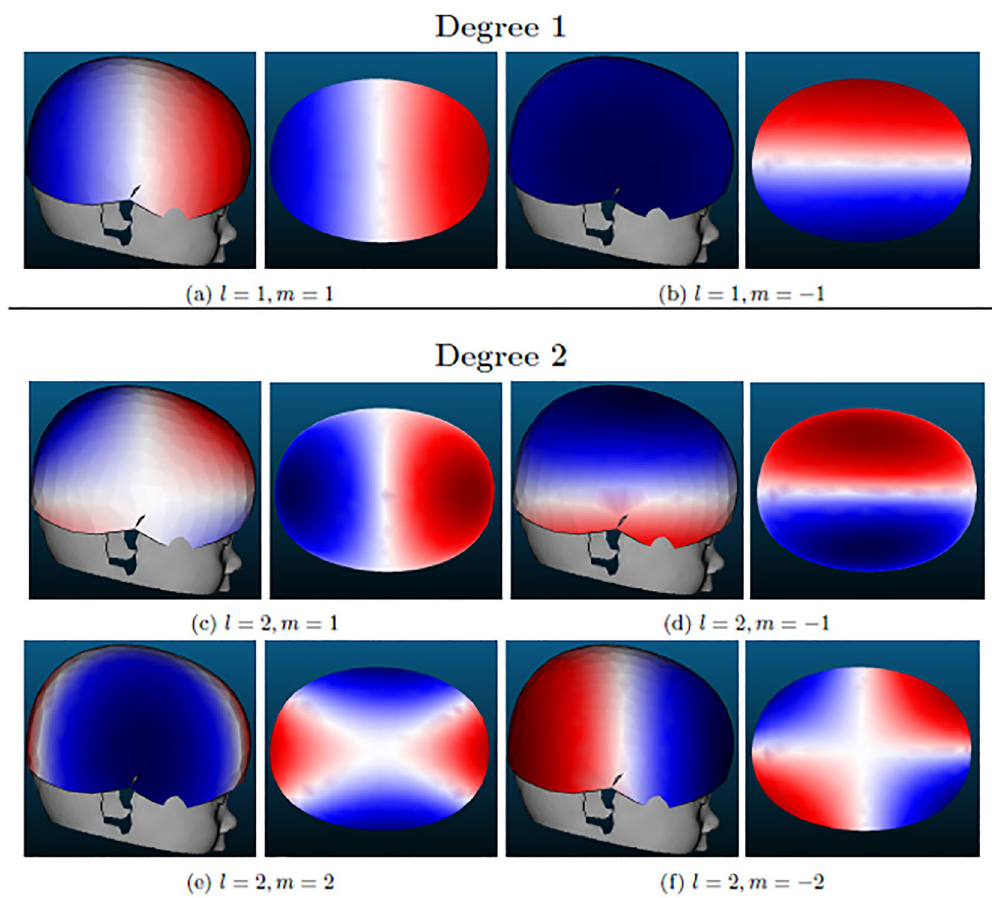
Figure 3. Visualization of spherical harmonic functions of degree l = 1 and l = 2 (excluding those of order m = 0) on the right-hand side (lateral) view and the top view. Red and blue symbolize positive and negative function values, respectively.